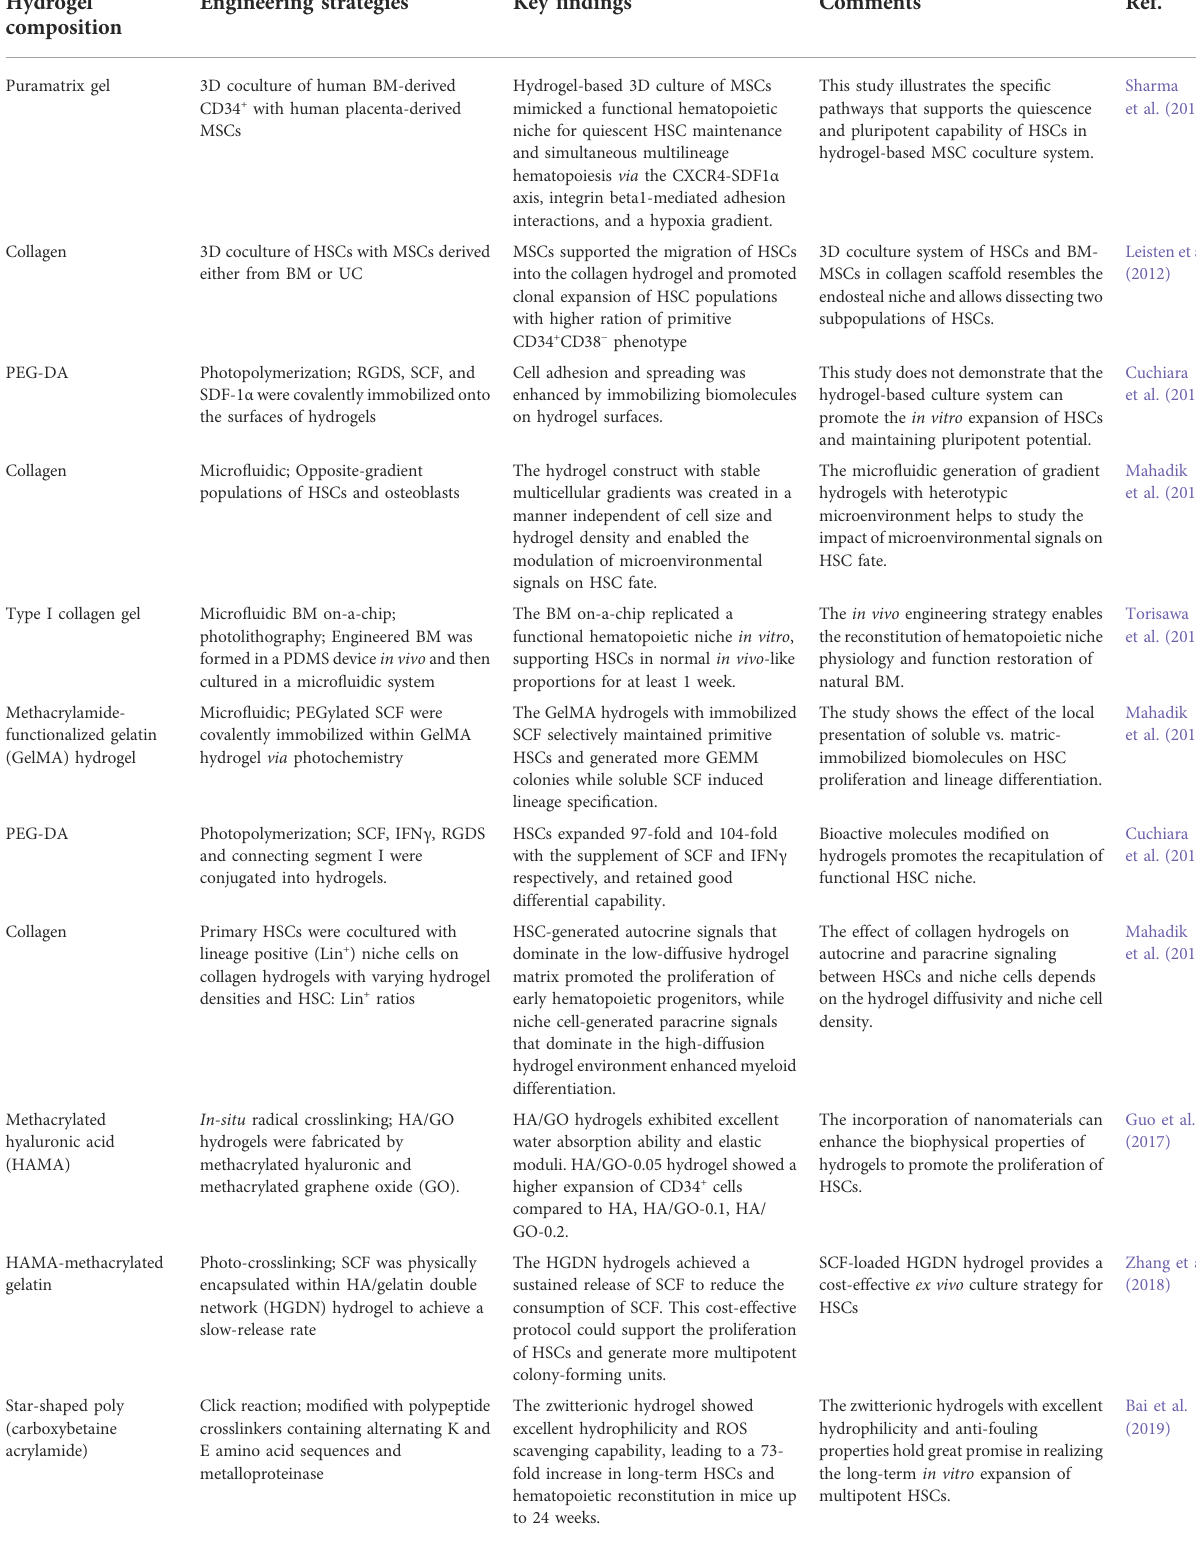
TABLE 1 Engineering hydrogel strategies of biomimetic hematopoietic niche and in vitro HSC